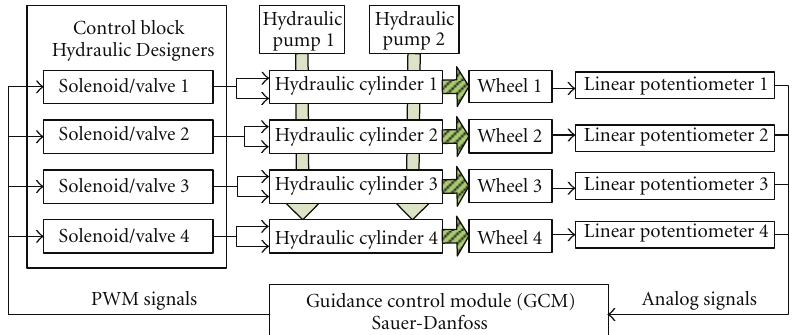
Figure 4: Schematic of the robotic platform guidance system.